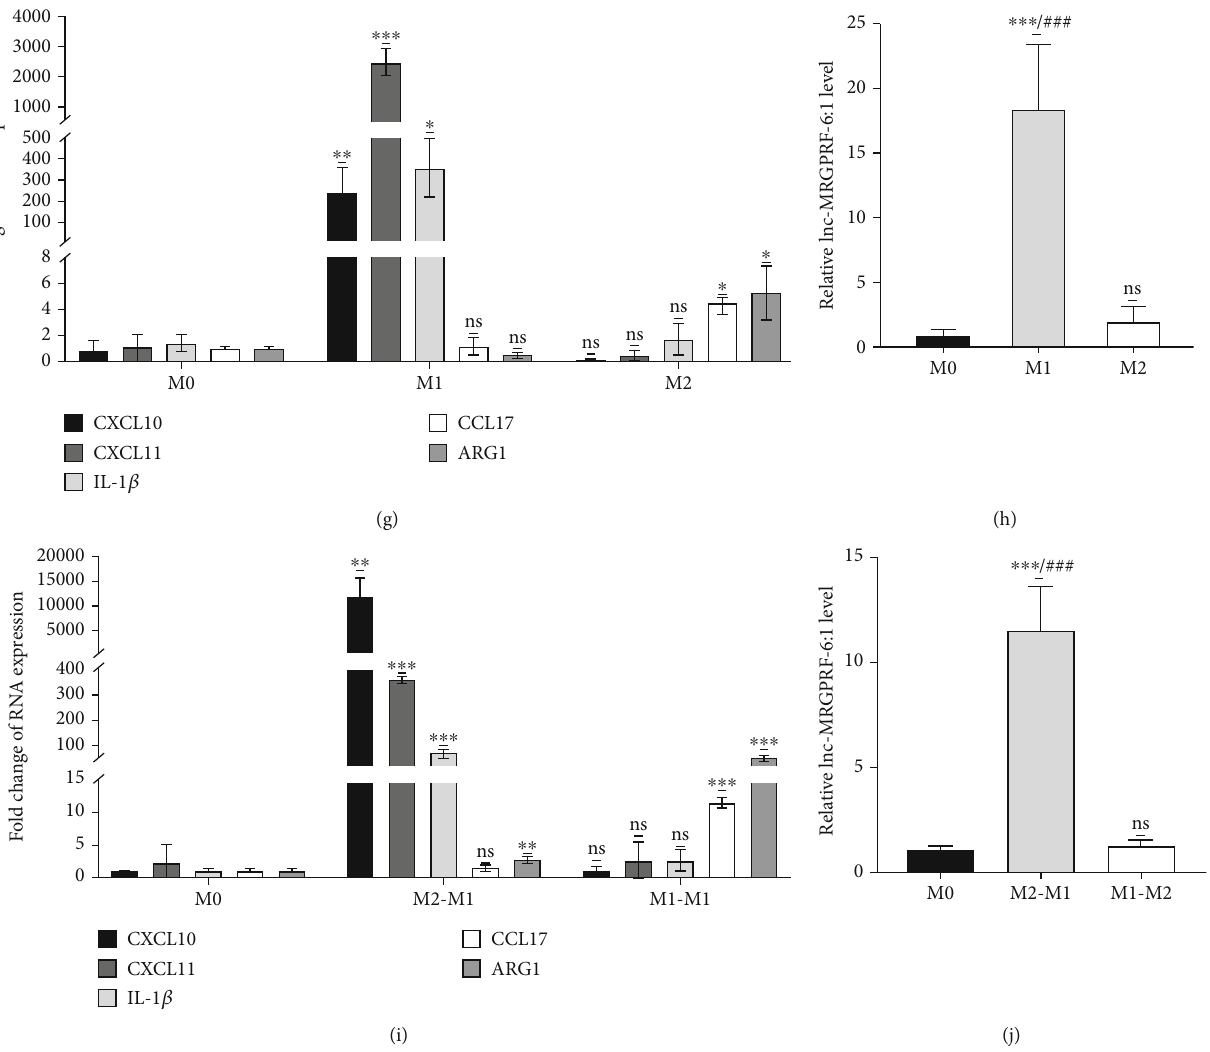
Figure 3: lnc-MRGPRF-6:1 was highly expressed in M1 macrophage. (a, b, g) M1 polarization was stimulated by IFN- γ /LPS, and M2 polarization was stimulated by IL-4. The levels of TNF- α , TNF- β , and IL-10 in the supernatant were detected by ELISA, and the mRNA levels of CXCL10, CXCL11, IL-1 β , ARG1, and CCL17 were detected by RT-qPCR. (c, h) The expression levels of lnc-MRGPRF-6:1 in macrophages with di ff erent phenotypes were detected by RT-qPCR. (d, e, i) After repolarization, CXCL10, CXCL11, IL-1 β , ARG1, and CCL17 levels were detected by RT-qPCR, and TNF- α , TNF- β , and IL-10 were detected by ELISA. (f, j) The expression levels of lnc- MRGPRF-6:1 in repolarization macrophages were detected by RT-qPCR. (a – c, g, h) M1/M2 vs. M0, ns: not statistically signi fi cant; ∗ P